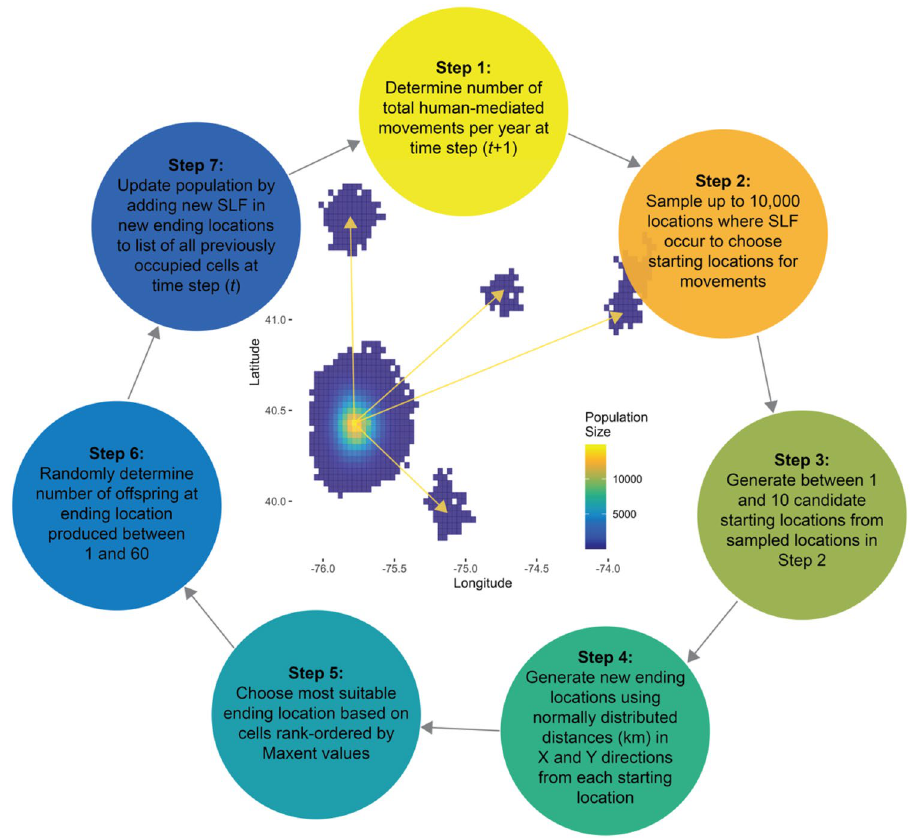
Figure 3. Generalized description of the algorithm used to simulate the human-mediated movement process component of our